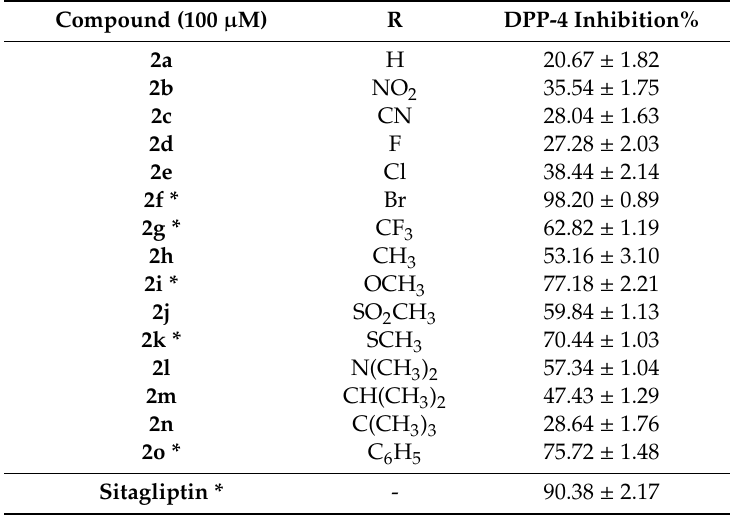
Table 1. The percentage inhibition values of compounds 2a – o and sitagliptin for DPP-4.